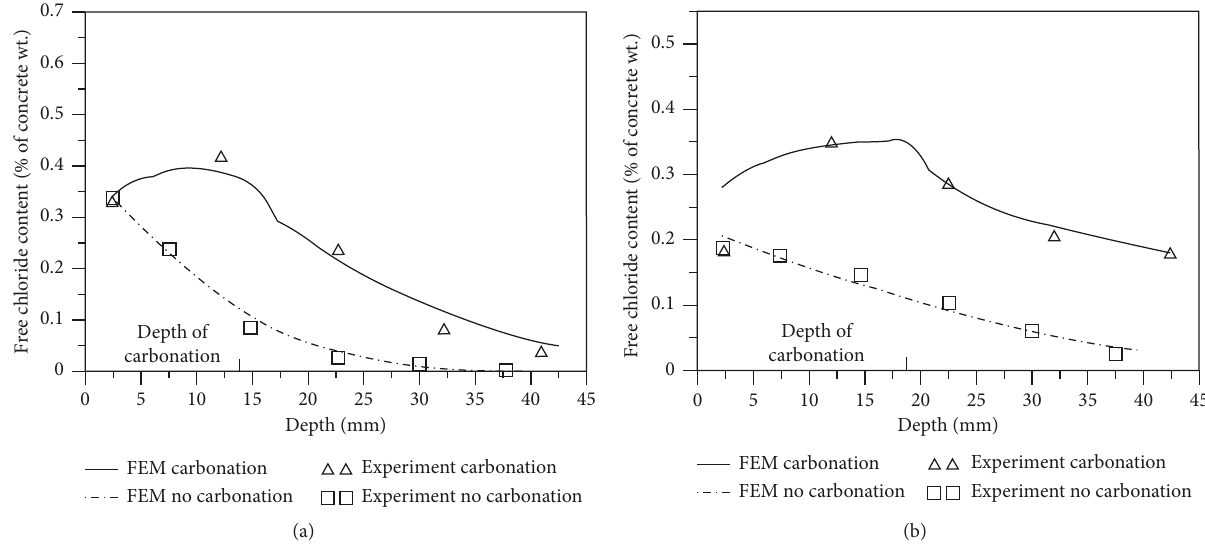
Figure 3: Concentrations of free chloride ions with respect to the depth of the specimen for (a) fly ash concrete and (b) Portland